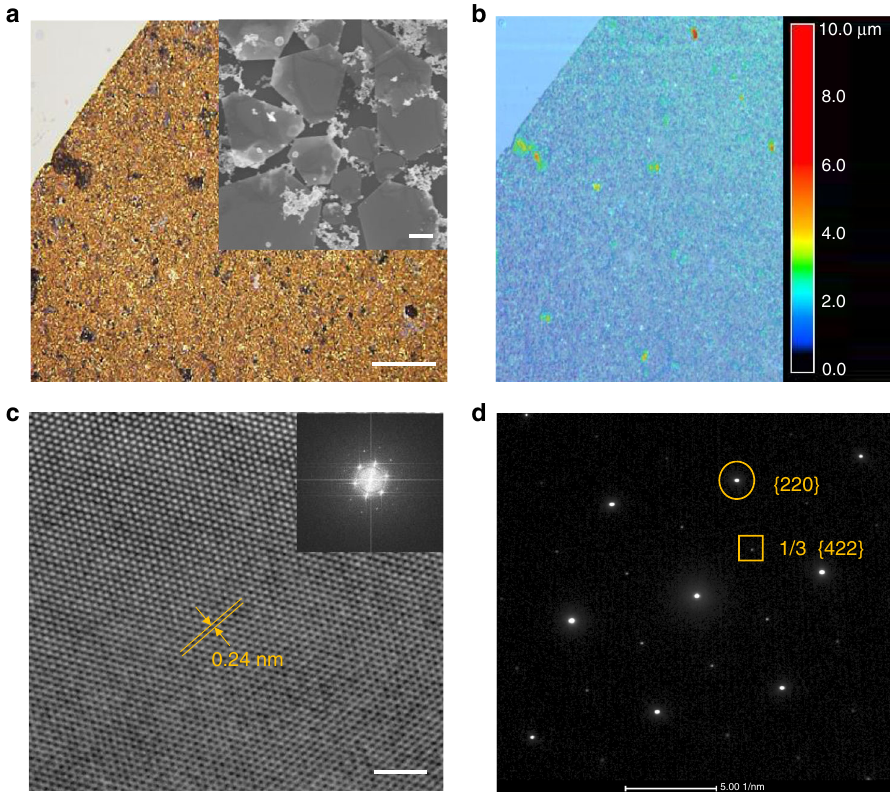
Fig. 2 Structural characterizations of nanosheets directly transferred from the interface. a , b The as-prepared gold nanostructure assemblies at the interface were transferred onto a silicon wafer by pipette and subsequently detected under 3D laser scanning microscopy. The re fl ection microscope image ( a ) and 3D height map ( b ) of the gold nanostructure assemblies showed homogenous colour, indicating a relatively fl at surface. The inserted SEM image in ( a ) showed that the gold nanostructure assemblies were mainly composed of nanosheets. Scale bar: 100 μ m; inset: 1.0 μ m. c A high-resolution transmission electron microscopy (TEM) image and (inset) corresponding fast Fourier transform diffraction pattern of a typical gold nanosheet. Scale bar: 2.0 nm. d Selected-area electron diffraction pattern of a gold nanosheet. The bright spot patterns were assigned to {220} (circled spot) and 1/3 {422} (boxed spot) Bragg re fl